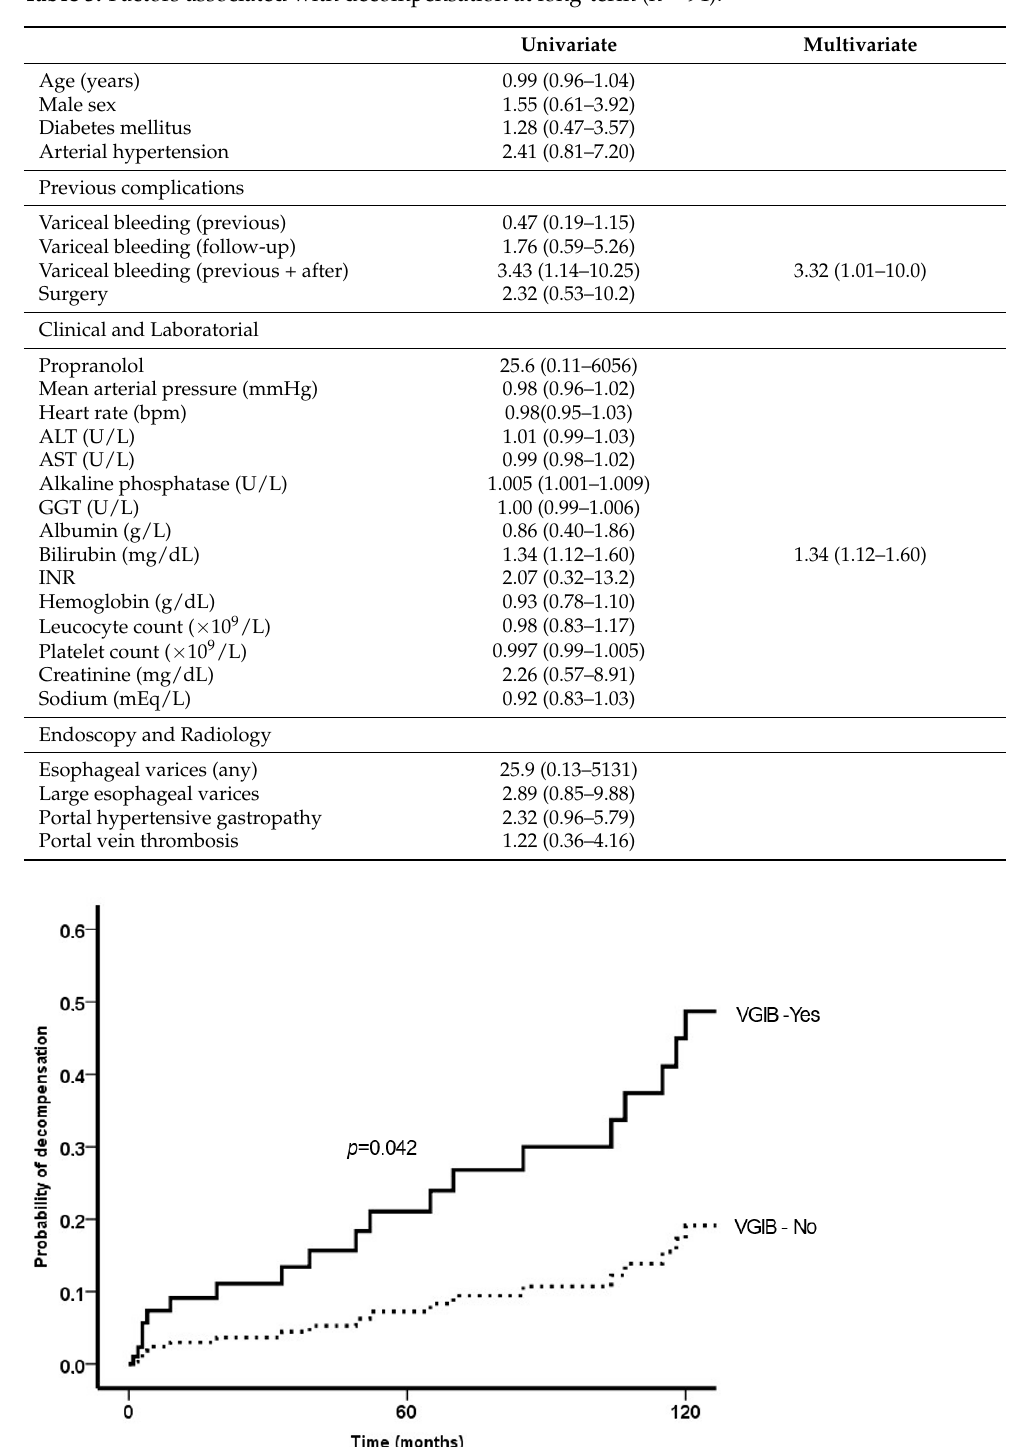
Table 3. Factors associated with decompensation at long-term (n = 94).